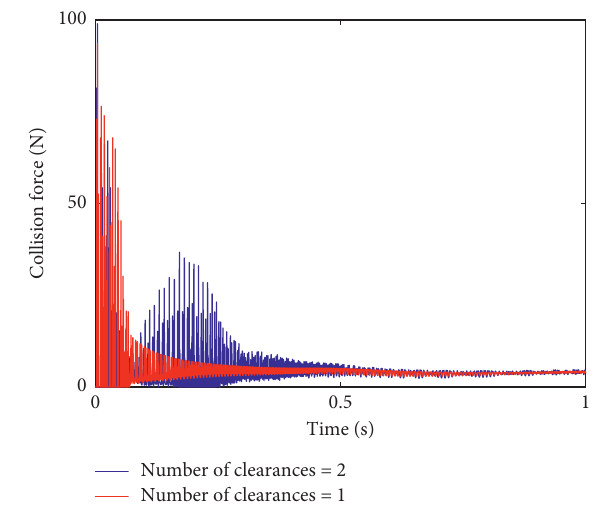
Figure 10: Velocity of the slider with different numbers of clearances.